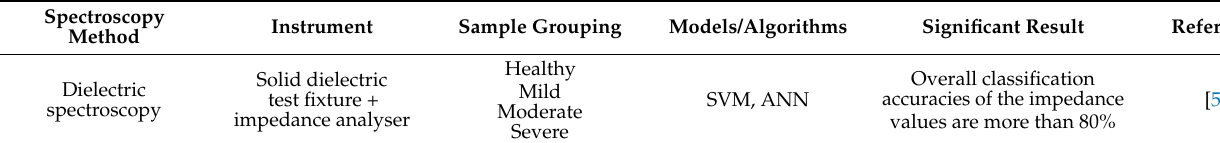
Table 2. Previous studies on G. boninense detection using spectroscopy